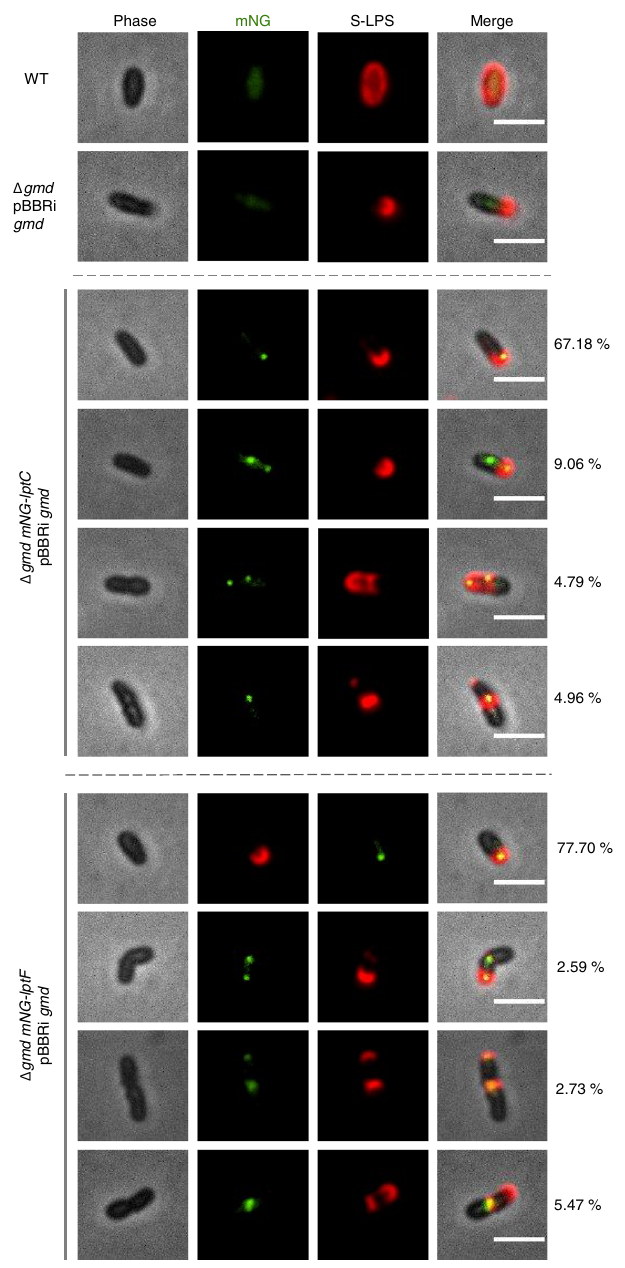
Fig. 3 | S-LPS induction in mNG-lptC and mNG lptF . The gmd synthesis was induced upon IPTG addition in exponential phase culture and the bacteria were labelled for S-LPS using the monoclonal antibody B66/04F09 targeting the B. abortus O-antigen.Intotal,94.36or94.09%ofthebacteriadisplayedcolocalization signalforS-LPSandLptCorLptFrespectively.Mostofthebacteriawerefoundwith onefocusofLptCorLptFcolocalisingwithS-LPSincorporationatthesamepoleor colocalizing at the division site. The WT strain was used as a positive control for O antigen labelling and the Δ gmd ::pBBRi gmd strain wasused asa positive control of induction and polar detection of newly inserted S-LPS. N =585 bacteria for mNG- lptC and n =688 bacteria for mNG-lptF . The analysis represents three biological replicates. Scale bar is 2 µ m. Source data are provided as a Source Data fi